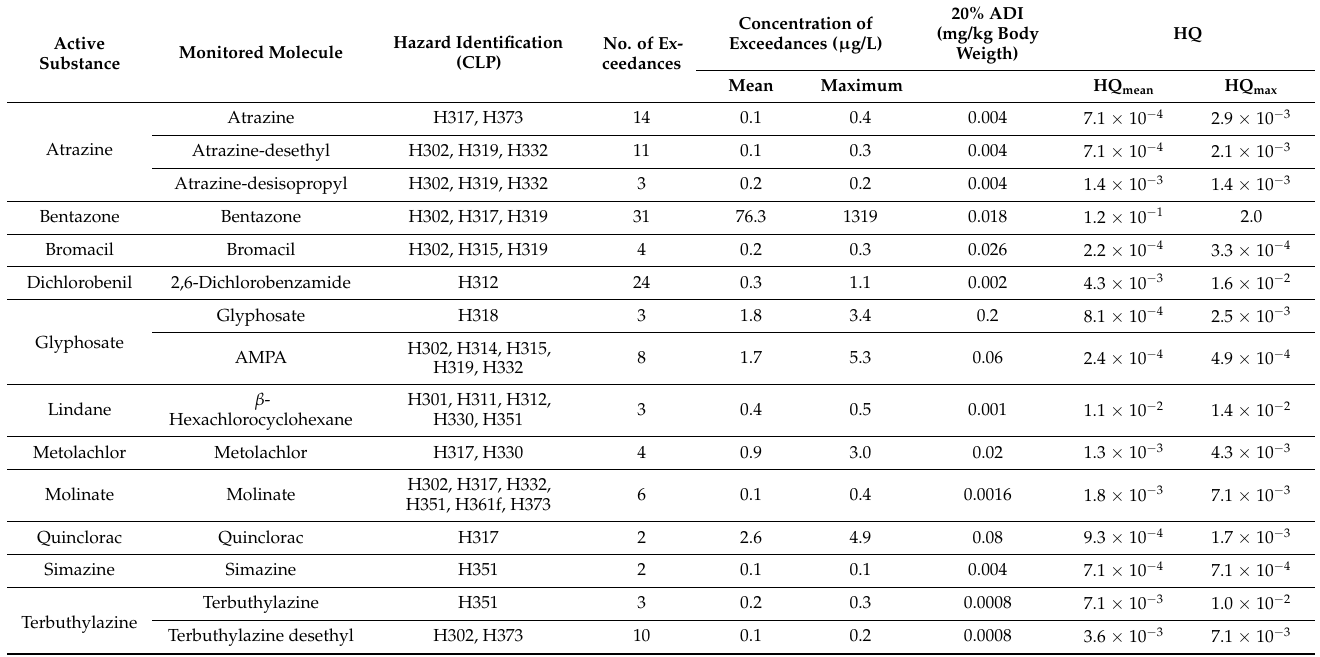
Table 5. Active substances for which at least one exceedance of the EQS single was observed, number of exceedances and measured concentrations, acceptable daily intake (ADI) and hazard quotient (HQ) for the health risk for an adult ingesting 2 L of drinking water per day, based on the mean and maximum concentrations.